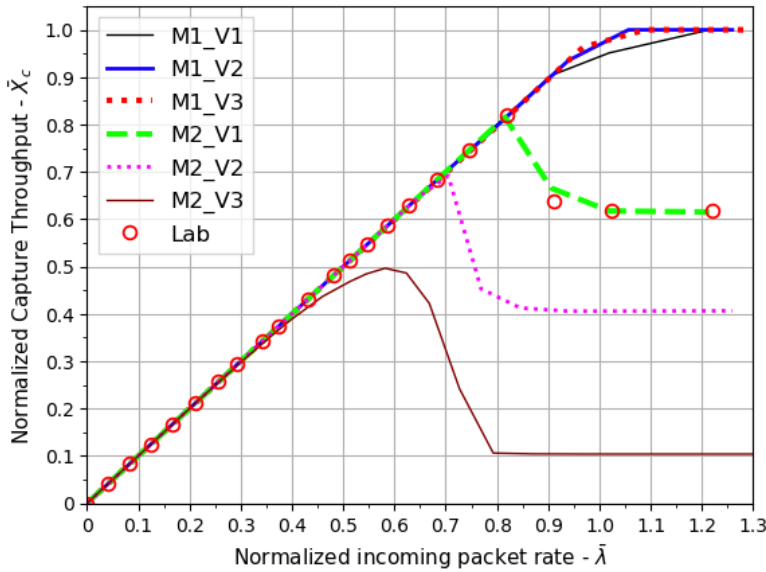
Figure 7. Results of normalized capture throughput for different scenarios (V1, V2, and V3).